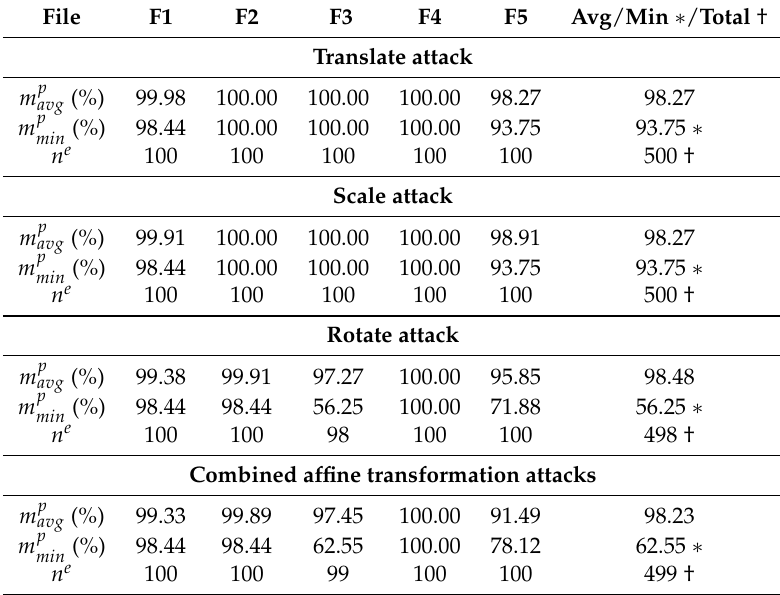
Table 4. Affine transformation